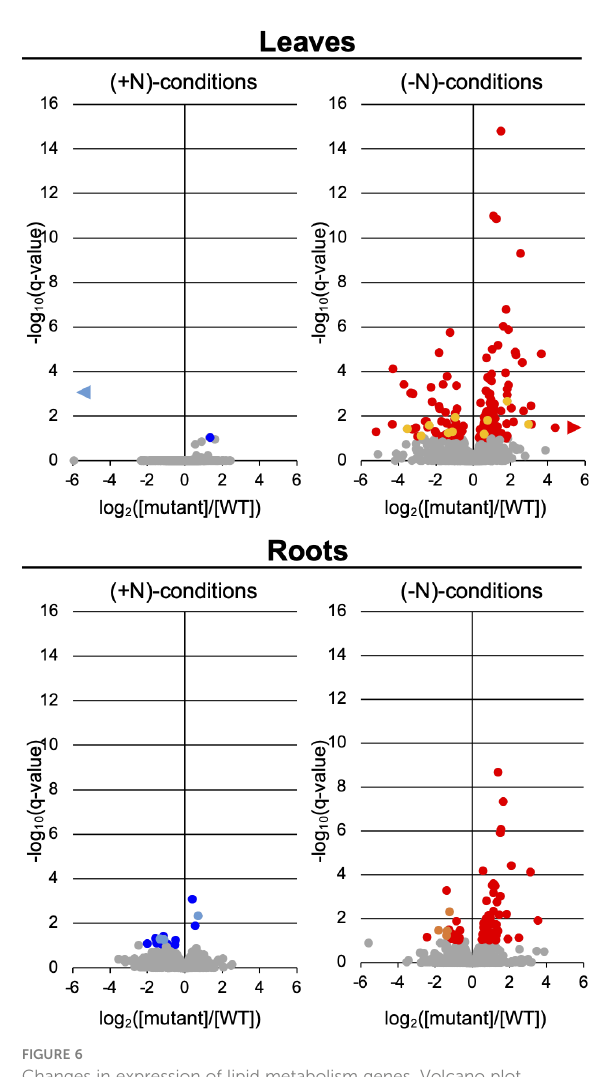
FIGURE 6 Changes in expression of lipid metabolism genes. Volcano plot visualization of lipid metabolism DEGs, comparing relative abundance of individual transcripts in the atg7 - ( ● , ● ) or atg9 -mutant ( ● , ● ), in leaves and roots from plants grown either in (+N)-or (-N)-conditions. Grey data-points ( ● ) represent transcripts whose relative abundance is statistically indistinguishable in these comparisons (q > 0.1). Data points that are out of the range of the x-axis are identi fi ed by horizontal isosceles triangles ( ► ), which point to the direction of the data-point, either to the left or right of the zero x-axis value. Lipid metabolism genes were identi fi ed in AraLip (Li-Beisson et al., 2013).